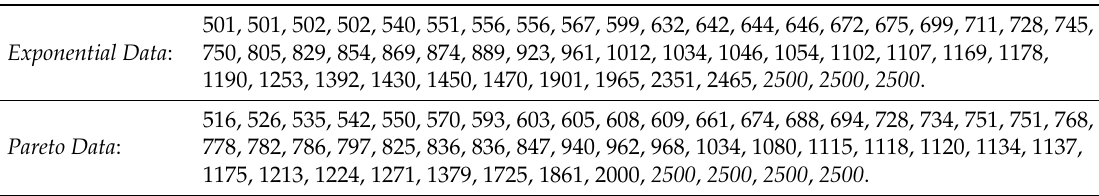
Table 1. Left-truncated (at t = 500) and right-censored (at u = 2500) data simulated from the exponential ( x 0 = 100, θ = 500) and Pareto ( x 0 = 100, α = 1.50) distributions.